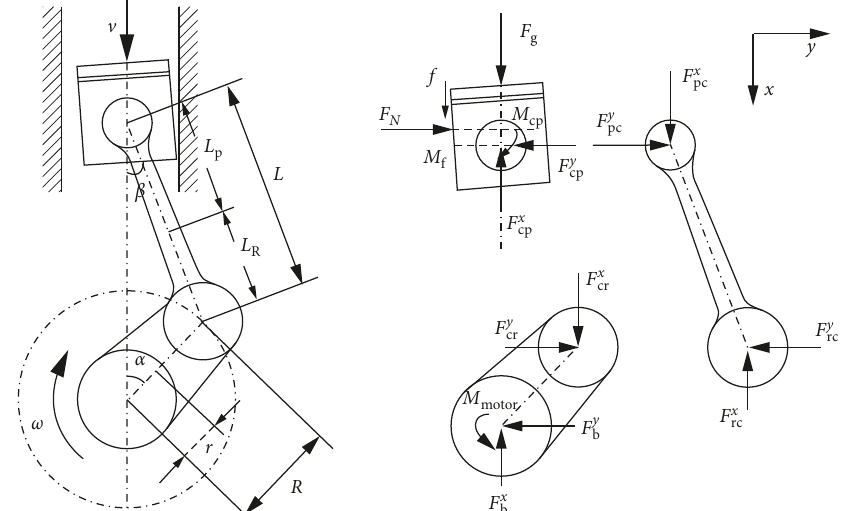
Figure 5: Piston and connecting rod geometry and forces.